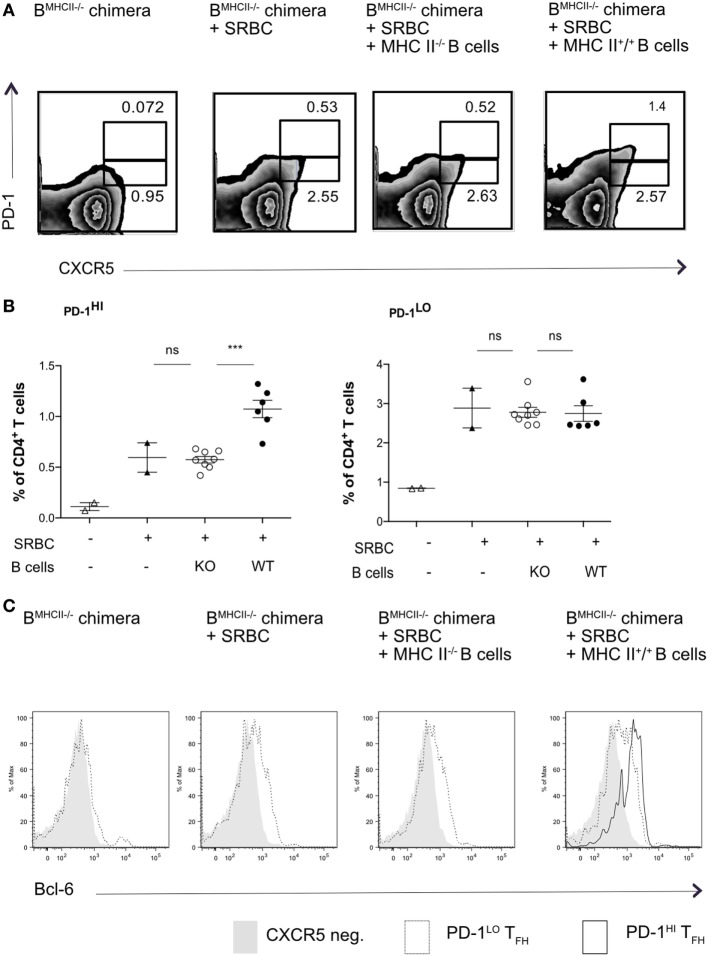
Transfer of WT B cells rescues PD-1hi T follicular helper cells (Tfh) formation. B-MCHII−/− chimeric mice were generated as described in the Section “Materials and Methods.” After reconstitution (8–10 weeks), mice were immunized with SRBC and thereafter sorted (97% pure) B cells (1 × 106/mouse i.v.) derived from mice sufficient or deficient of MHC-II were adoptively transferred on the day of SRBC immunization. After 5 days, mice were analyzed for the presence of Tfh-phenotype cells, as described by the co-expression of CXCR5 and PD1 (A,B) and the transcription factor, Bcl-6 (C). (A) Representative flow cytometry of PD-1hi and PD-1lo Tfh-like cell populations from each of the experimental groups (labeled on top row). (B) Summary of PD-1hi and PD-1lo Tfh-like frequencies in each of the experimental groups. (C) Representative flow cytometry plots of Bcl-6 expression in PD-1hi (bold black line) and PD-1lo (black line) Tfh and CXCR5− T (gray histogram) cells. The data are pooled from two independent experiments with two animals per group (B-MHCII−/− chimera, B-MHC II−/− chimera + SRBC) or four animals per group (B-MHC II−/− chimera + WT or KO B cells); each dot represents one mouse. Statistical significance was determined by one-way ANOVA with post-ANOVA Tukey’s test for multiple comparisons.